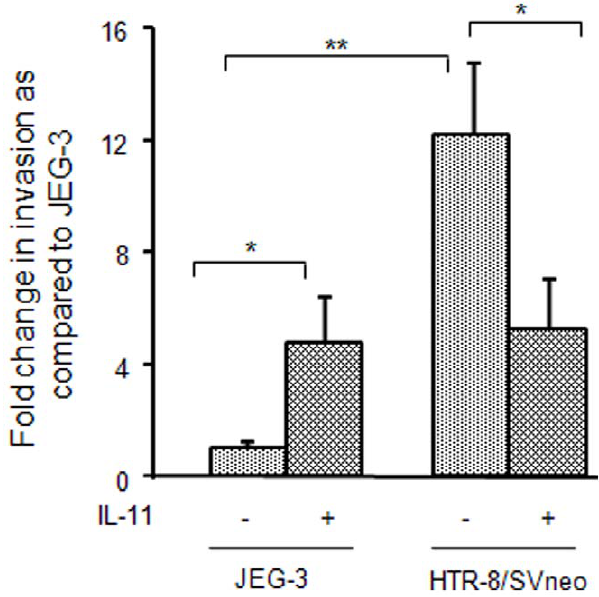
Figure 1. Effect of IL-11 on invasion of JEG-3 and HTR-8/SVneo cells. Invasion assay was performed as mentioned in Materials and Methods . Data is expressed as fold change in invasion following IL-11 (200 ng/ml) treatment as compared to untreated JEG-3 cells as control. Values are expressed as mean 6 SEM of at least 6 experiments performed in duplicates. *p , 0.05; **p ,